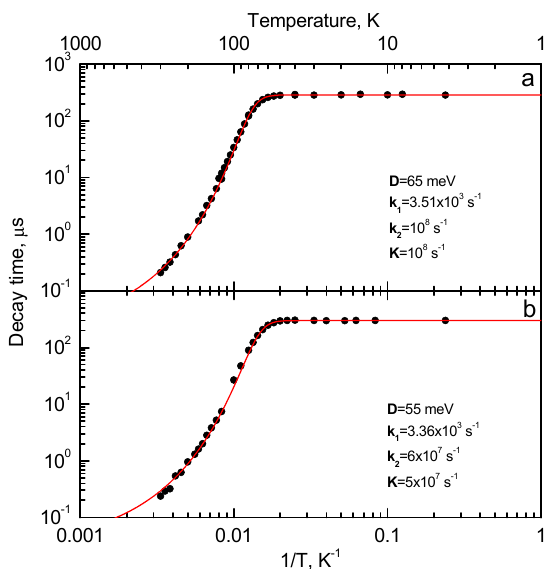
Figure 15. Temperature dependences of the decay times of the ( a ) 3.5 eV and ( b ) 3.3 eV emissions of Lu 2 SiO 5 :Bi measured under E exc = 4.15 eV and E exc = 3.9 eV, respectively. Solid lines are the best fits to experimental data of the two excited-state level models shown in Figure 6 (for details, see the text). The parameters of the fit are reported in the figures. Based on the data reported in [21], presented with the publisher’s